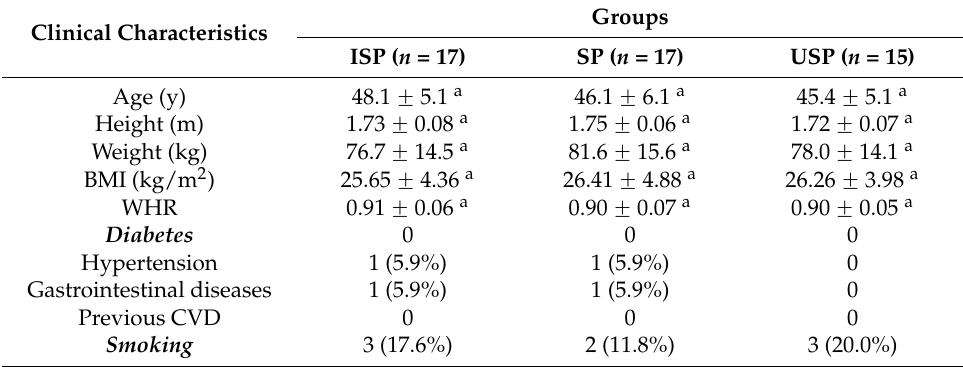
Table 2. Clinical characteristics at baseline of the 49 men involved in the study.